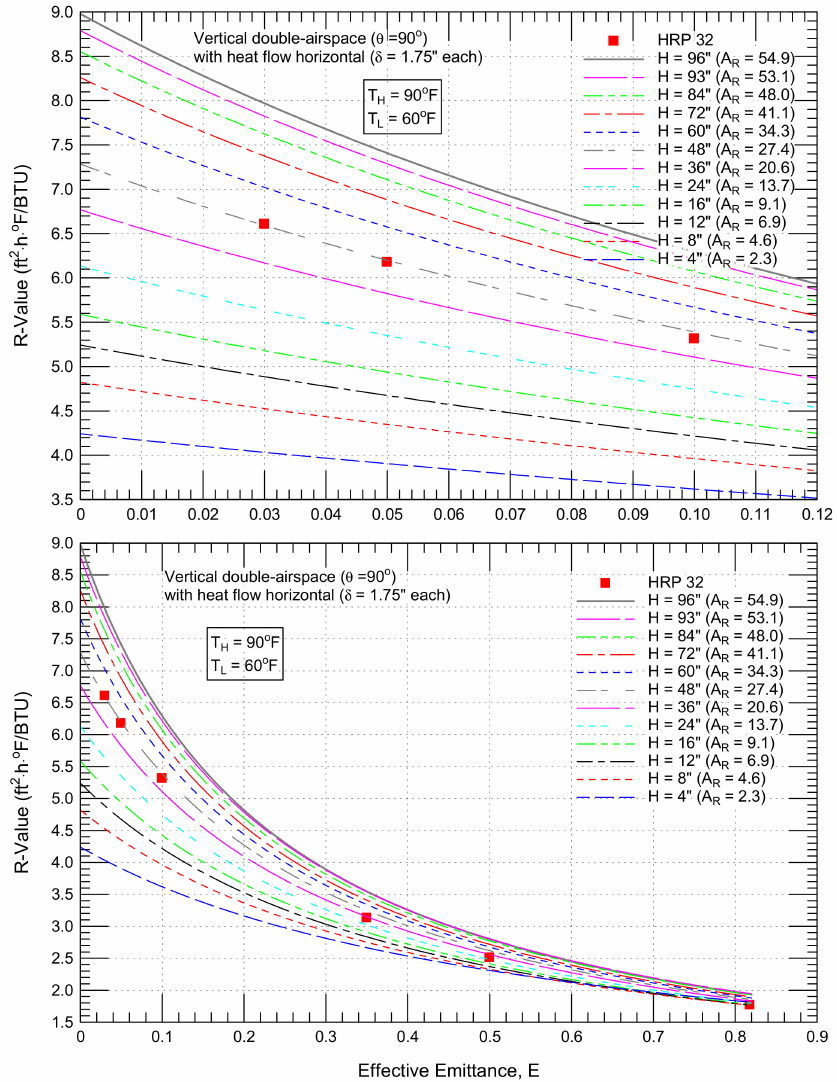
Figure 11. Comparisons of R values of HRP 32 [4] with present model predictions of various A R for double airspaces subjected to a horizontal heat flow ( θ = 90 ◦ , total δ = 3.5 inches, T H = 90 ◦ F, T L = 60 ◦